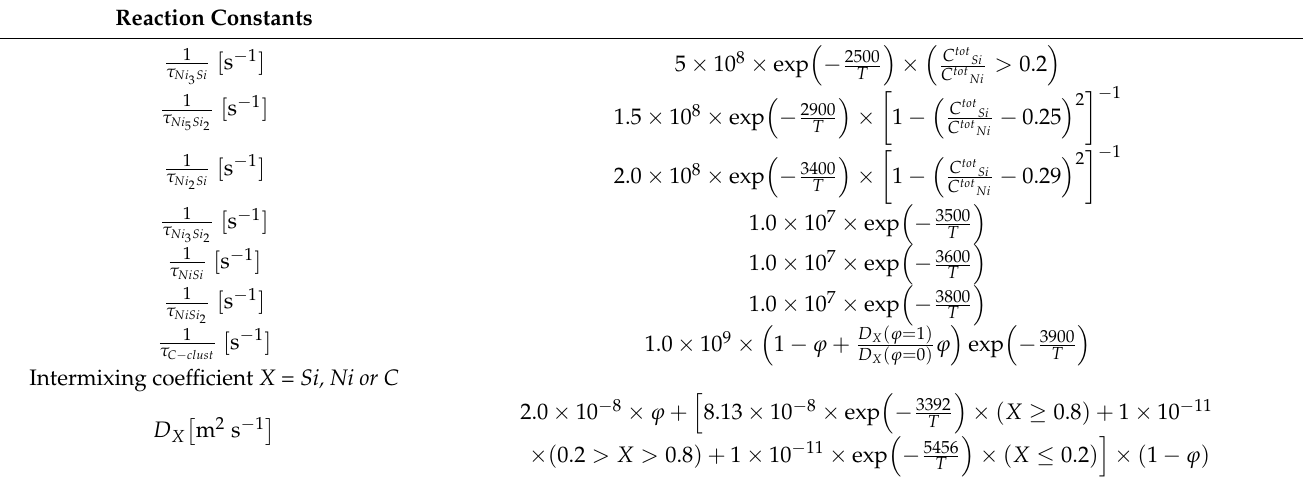
Table 4. (Calibration obtained in the present